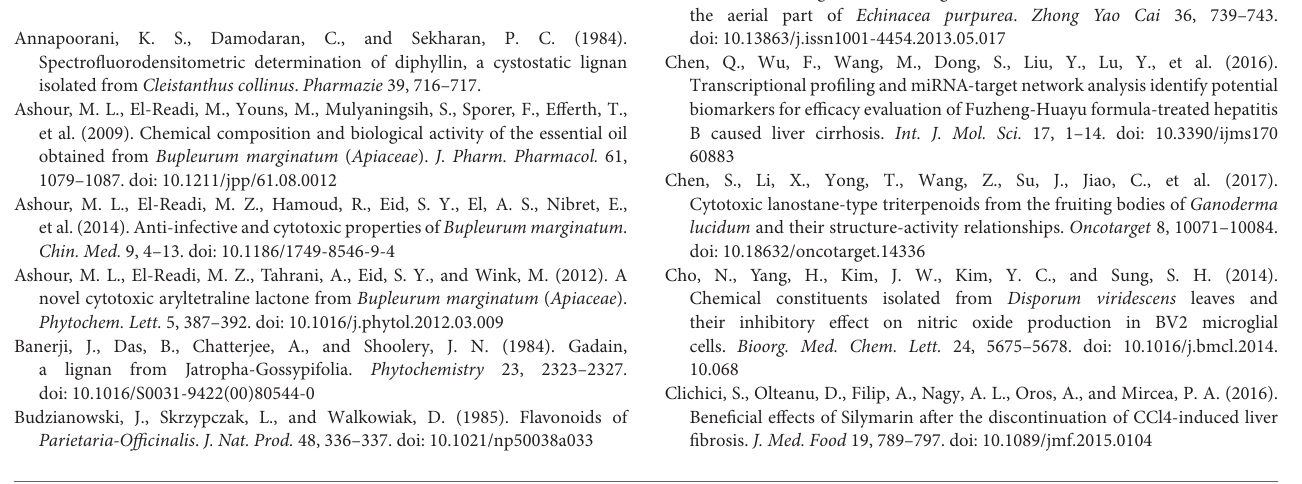
Supplementary Figure 3 | Effects of ZYCH on Masson’s trichrome staining changes of DMN-induced liver injury rats. Original magnification: 100 × . (A) Control group, (B) model group, (C) SC group, (D) L-ZYCH group, (E) M-ZYCH group, (F) H-ZYCH group, and (G) HR-ZYCH group. Supplementary Figure 4 | Hierarchical cluster analysis of differentially expressed proteins between H-ZYCH and DMN-model groups. The rows represent each protein and the column means different groups. The color in the graph indicates the relative expression of the protein in the sample, red represents the higher expression level and the green represents the lower expression. The left independent column represents the classification of the protein (10 classes). Supplementary Figure 5 | GO classification of all identified proteins, all altered proteins, up-regulated altered proteins and down-regulated altered proteins